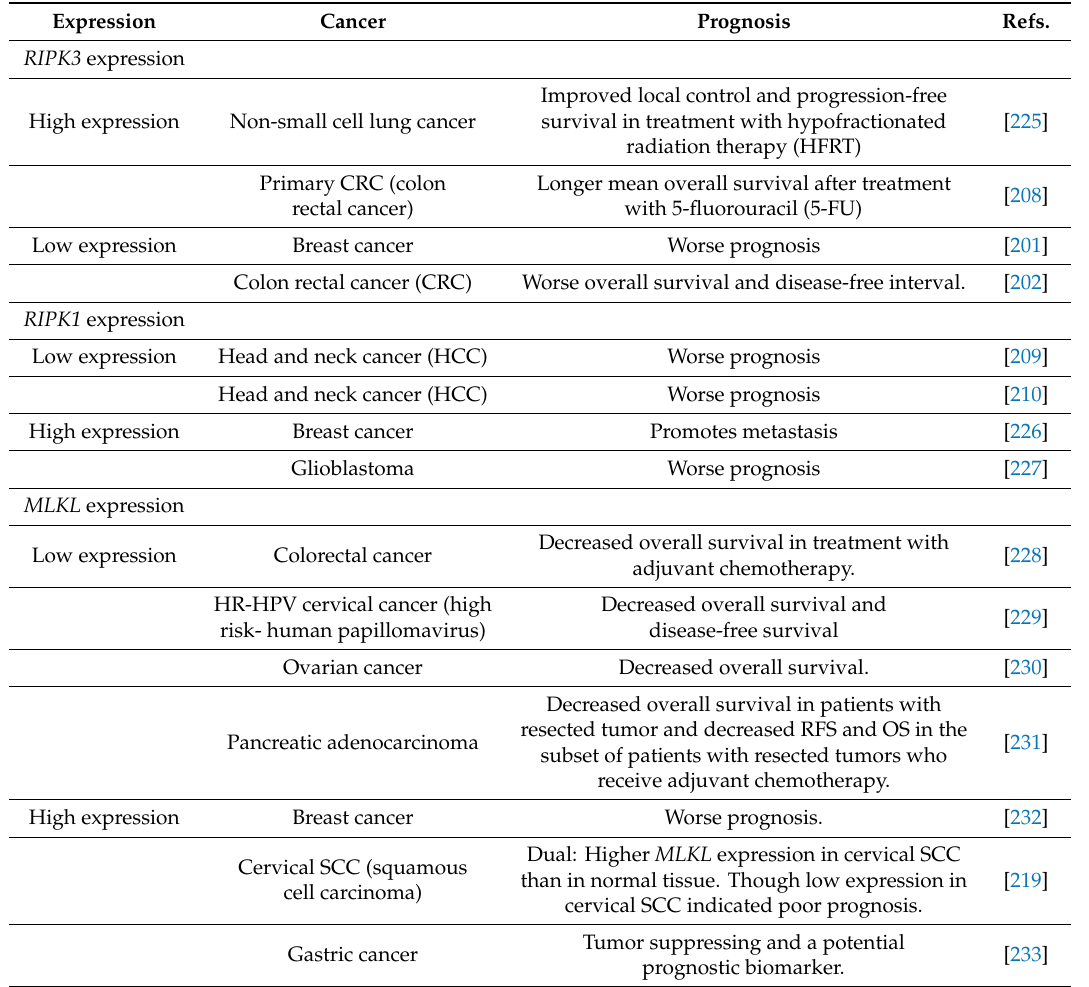
Table 3. Biomarker performance of pro-necroptotic genes in